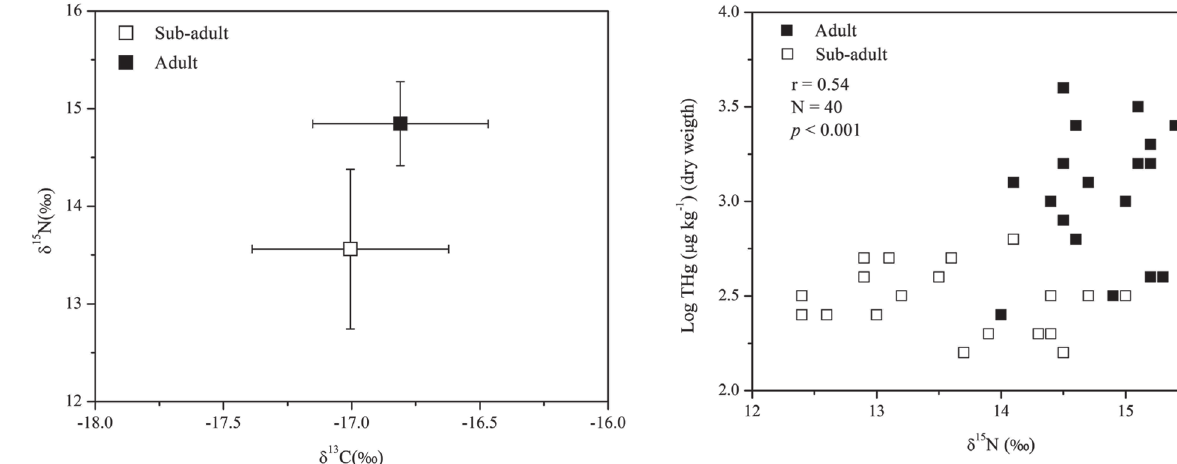
Fig. 3. Relationship between δ 15 N and δ 13 C in the muscle of sub-adult and adult specimens of Trichiurus lepturus . Bars represent the standard deviation.